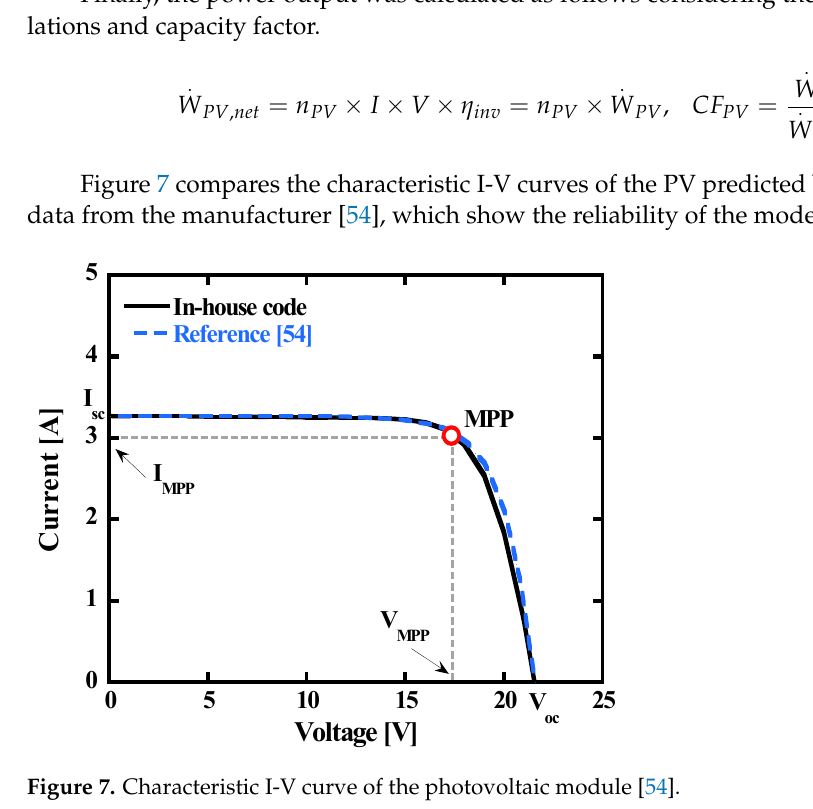
Figure 7. Characteristic I-V curve of the photovoltaic module [54].